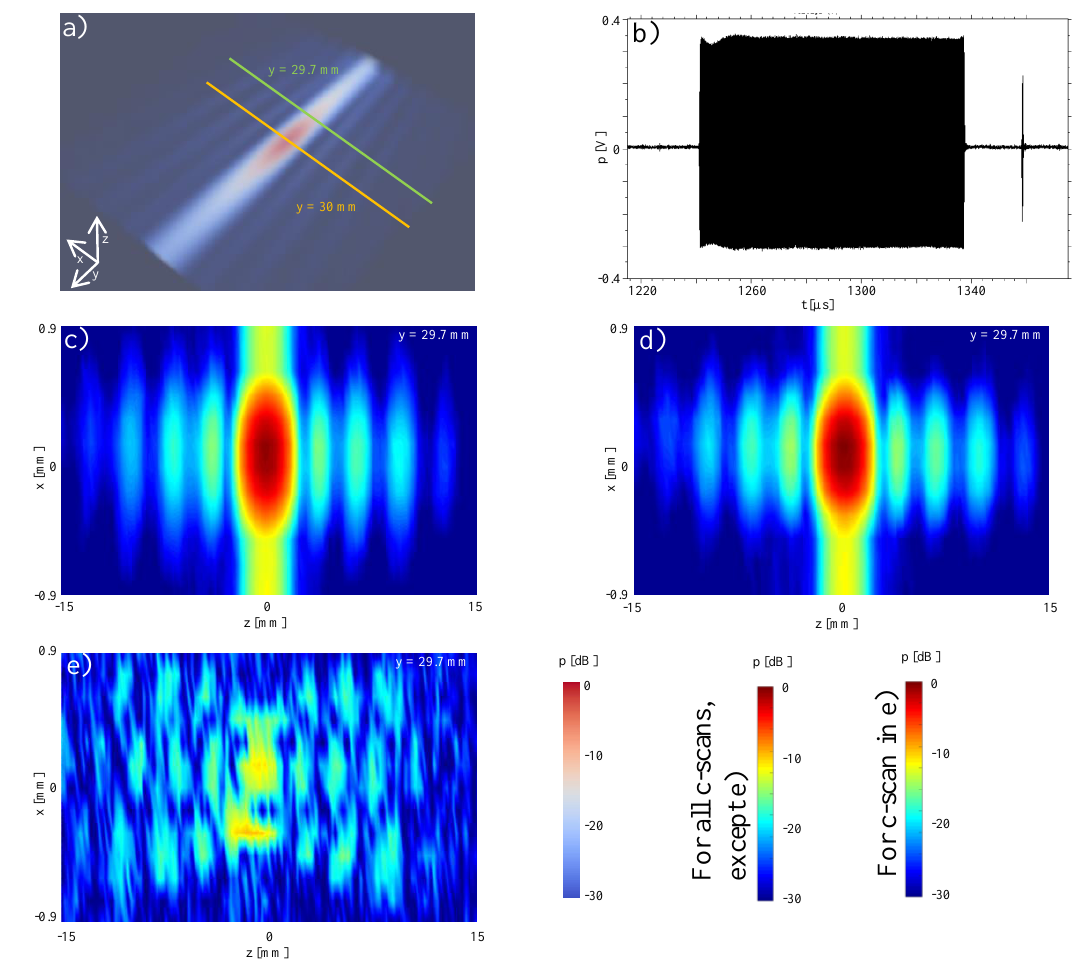
Figure 7. Characterization of an ultrasonic push: ( a ) 3-dimensional hydrophone measurement of a ultrasonic push; ( b ) time waveform of a push; ( c ) x , z -plane measurement; ( d ) x , z -plane re-radiation; ( e ) difference between measurement and